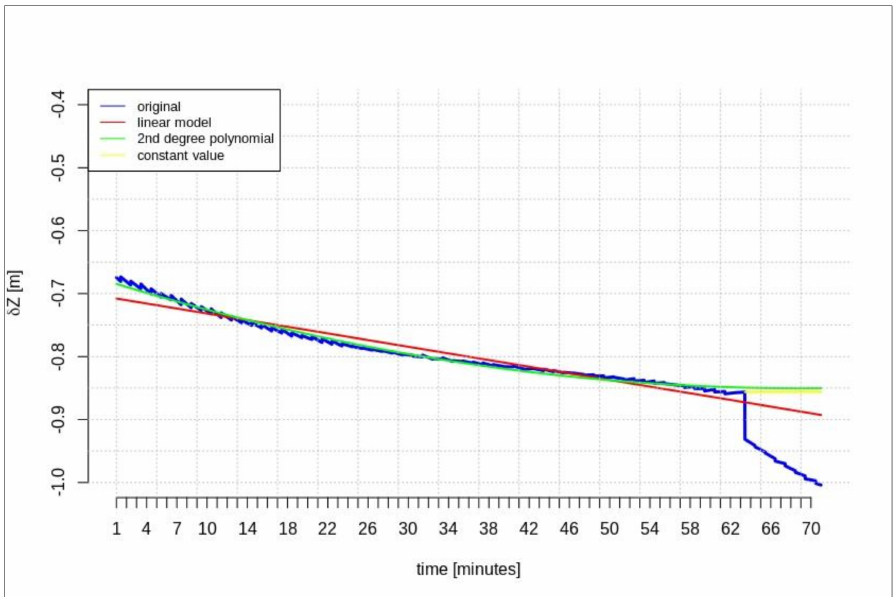
Figure 7. The results of the δ Z geocentric correction extrapolation (GPS G13) for a 70 min data-stream—the time series of the orbit corrections refer to an out-of-date navigation message. The next test was performed based on a 15-min correction stream (which is the minimum required data-stream for a 5 min prediction). Figures 8–10 show the results obtained in this scenario.